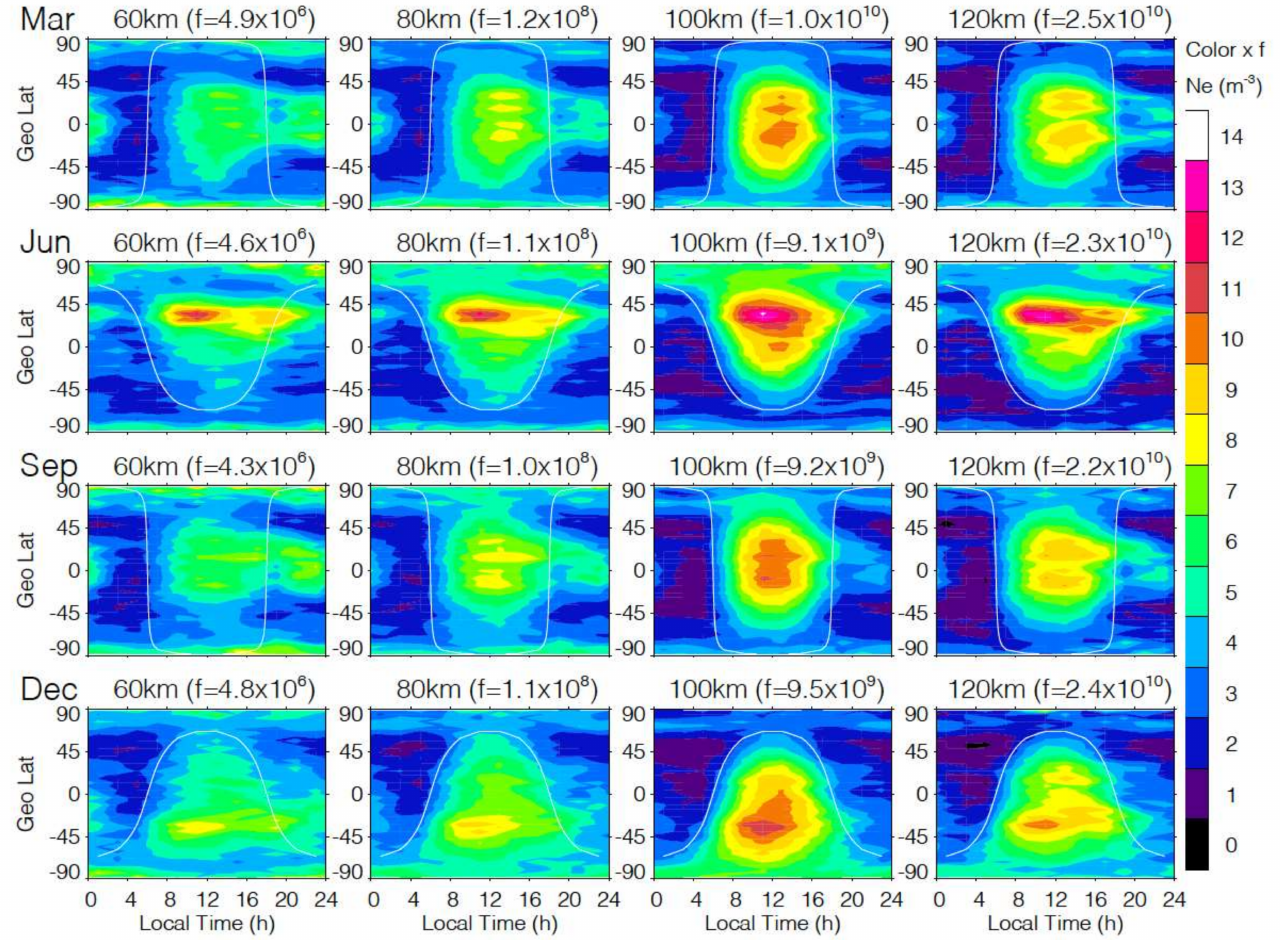
Figure 8. COMSIC-1 N e at 60, 80, 100, and 120 km as a function of LST and latitude for March, June, September, and December. The scaling factor for the color bar is indicated by the number in the parenthesis. The solid line denotes solar zenith angle χ = 90 ◦